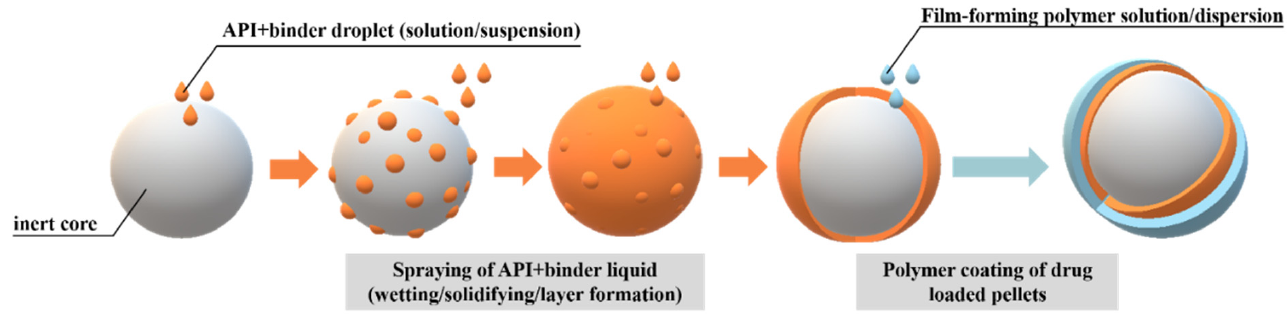
Figure 2. Schematic illustration of drug layering process of the active substance from solution/suspension and polymer coating.